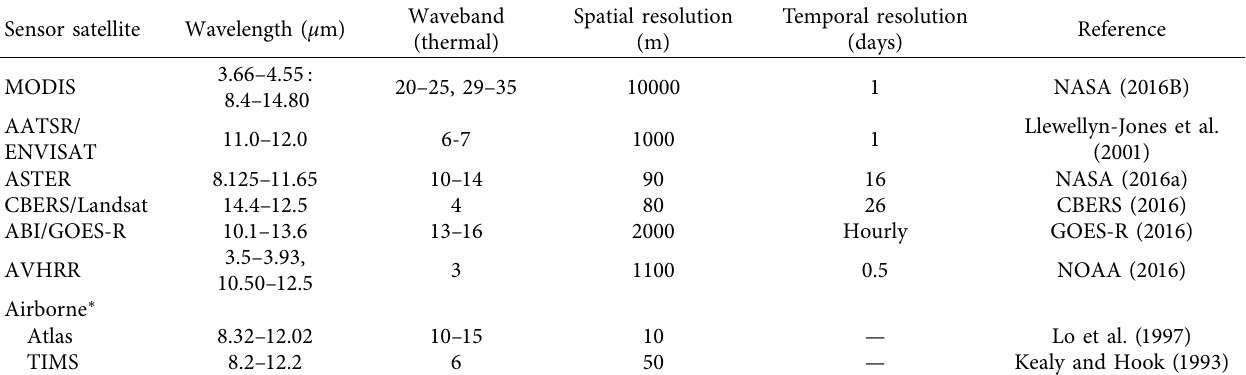
Table 1: Satellite and airborne thermal infrared sensors attached to platforms.